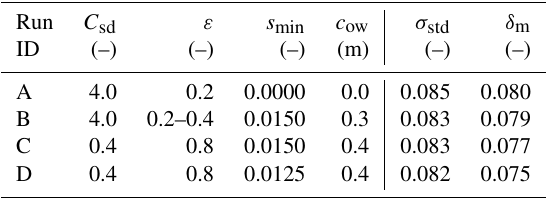
Table 2. Adjustable parameters of the model set-ups discussed in Sect. 4 and the corresponding statistical measures of the model per-